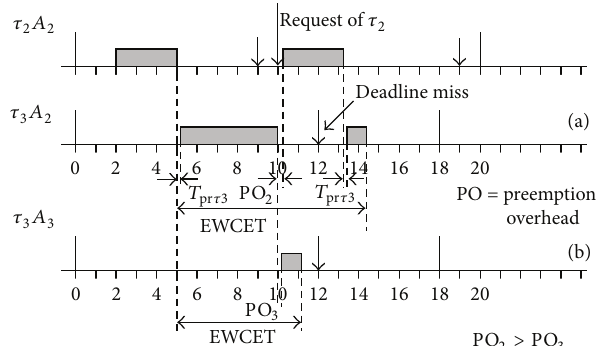
Figure 9: Schedule produced by dynamic reconfiguration in fully preemptive mode.